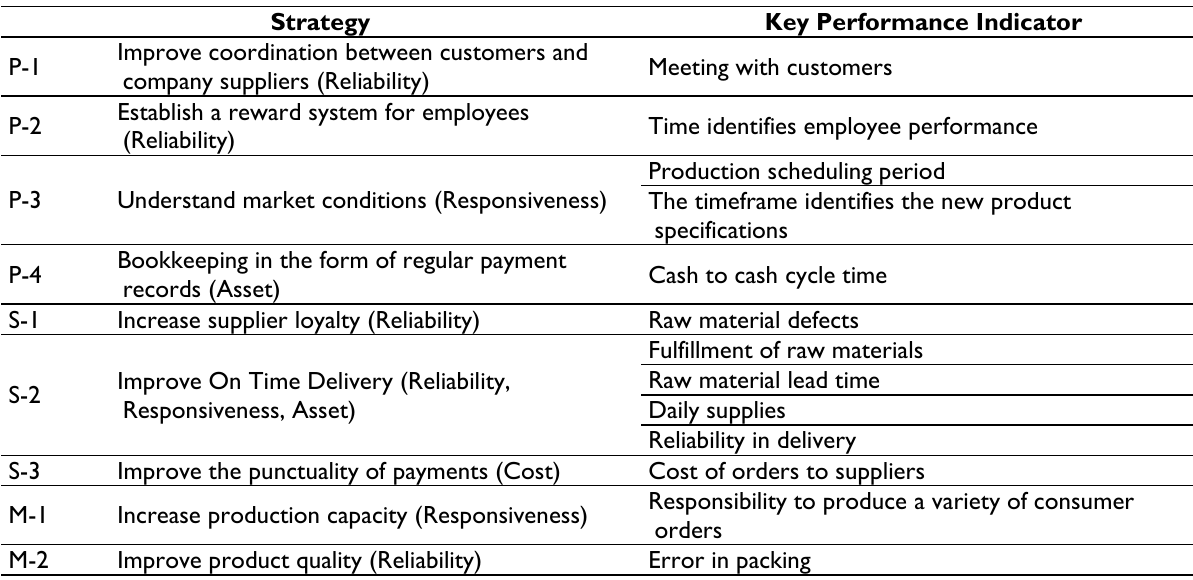
Key Performance